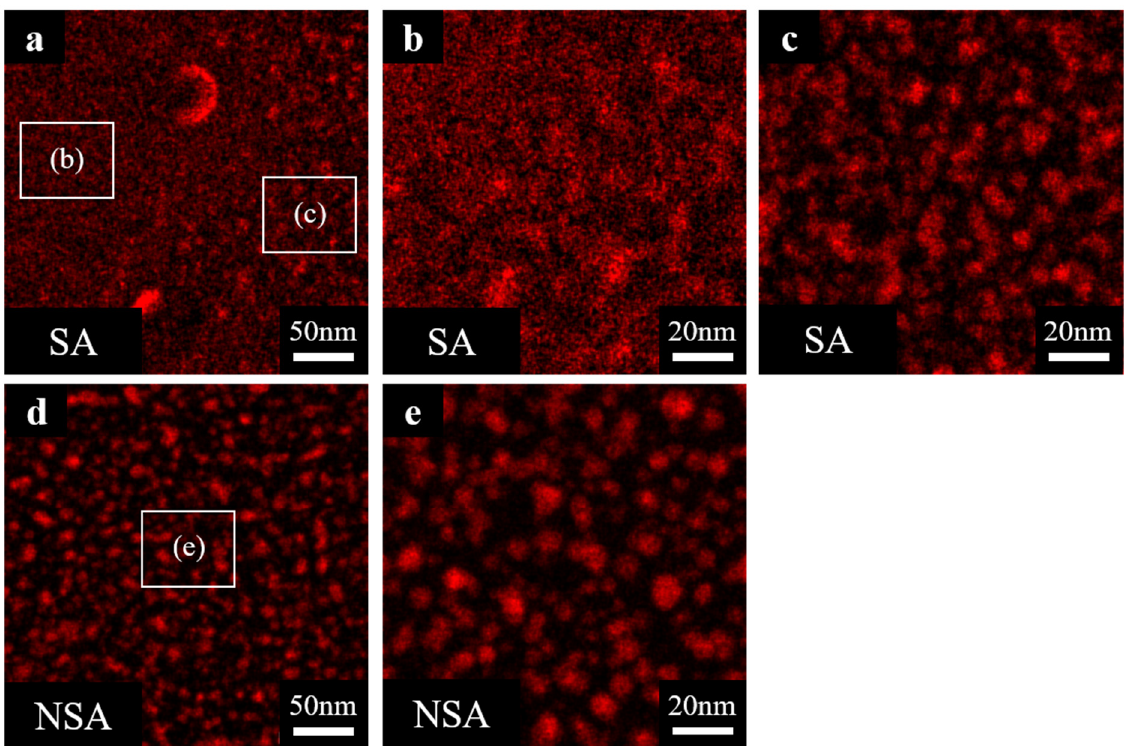
Figure 8. Comparison of TEM-EDS analysis of 17-4 PH SS showing nano-scale Cu-rich precipitation.